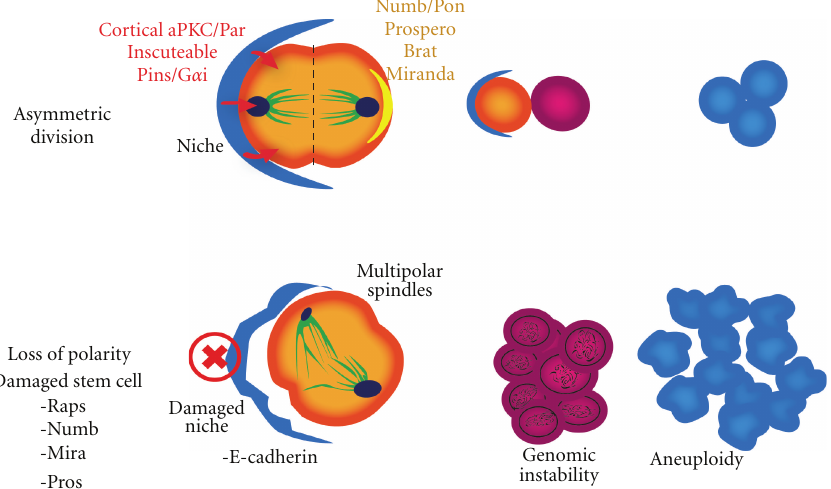
Figure 4: Stem cell polarity: homeostasis and dysregulation. Regulation of asymmetric division in the stem cell niche. The left panel represents spatial regulation of normal homeostasis, while the right panel demonstrates the loss of this asymmetry during carcinogenesis.